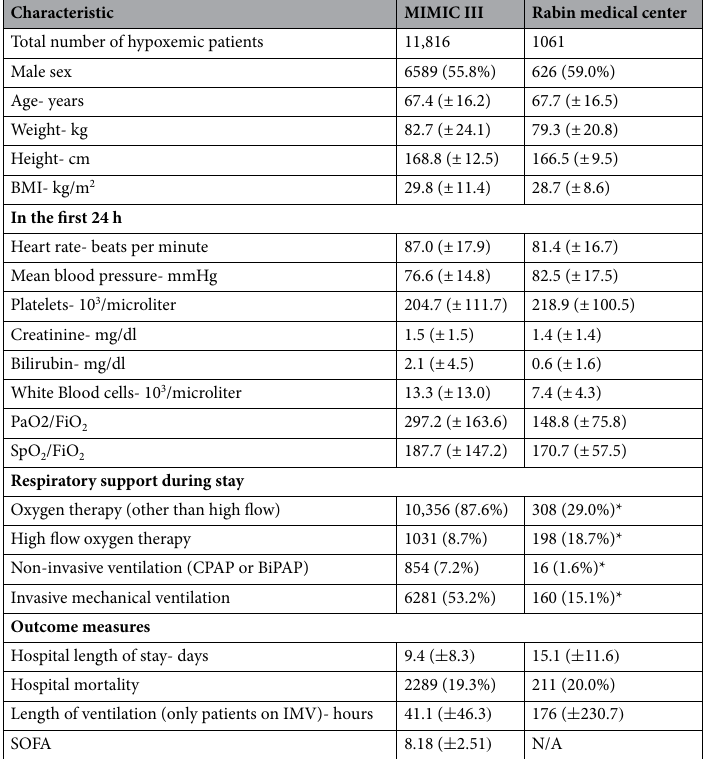
Table 1. Baseline characteristics for hypoxemic patients only in the MIMIC III and the Rabin COVID-19 cohorts. BMI body mass index, CPAP continuous positive airway pressure, BiPAP bilevel positive airway pressure, IMV invasive mechanical ventilation, N/A not available, SOFA sequential organ failure assessment. *Recorded means of noninvasive respiratory support in Rabin are very low. This could only be attributed to underreporting of the modalities